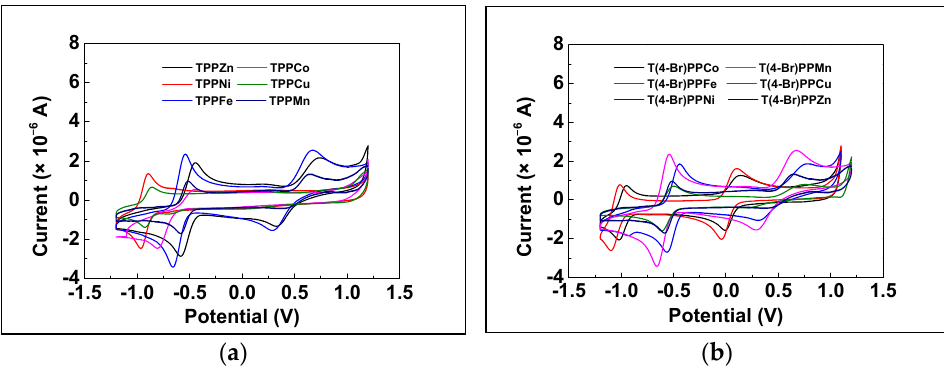
Figure 2. Cyclic voltammetric curves for metalloporphyrins ( a , b ).